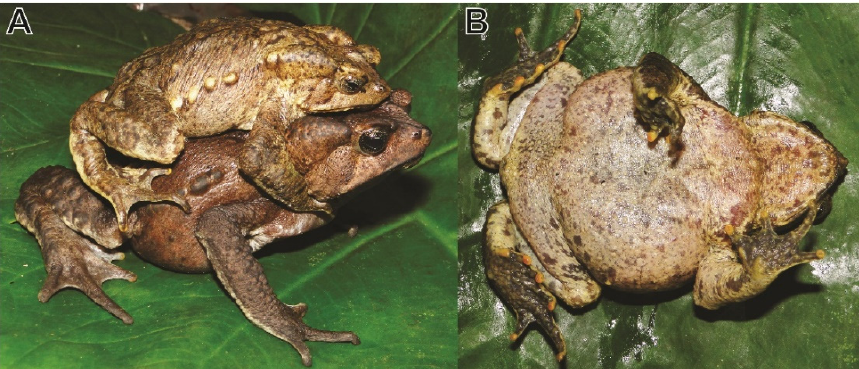
Figure 7. Male (CORBIDI 20371, SVL 70.8 mm) and female (CORBIDI 20372, SVL 91.6 mm) Rhinella moralesi sp. nov. in amplexus ( A ), male (CORBIDI 20371) in ventral view ( B ). Photos by L. A. García-Ayachi.